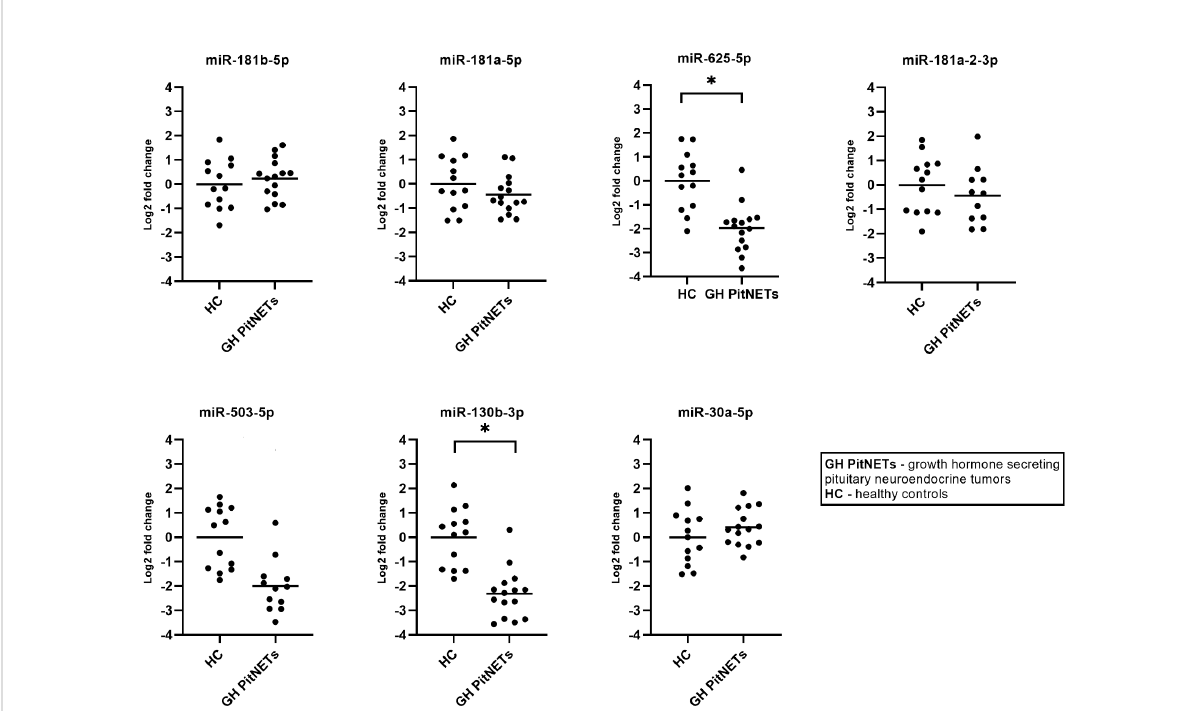
FIGURE 8 Expression by qPCR of seven candidate miRNAs in GH secreting PitNET patients ’ plasma (n = 15) vs healthy subjects plasma (n = 13). With “ * ” are marked changes with P < 0.05. P values were calculated using multiple linear regression by including the following facots: age, sex, body mass index, presence of tumor, treatment (somatostatin analogue treatment, no